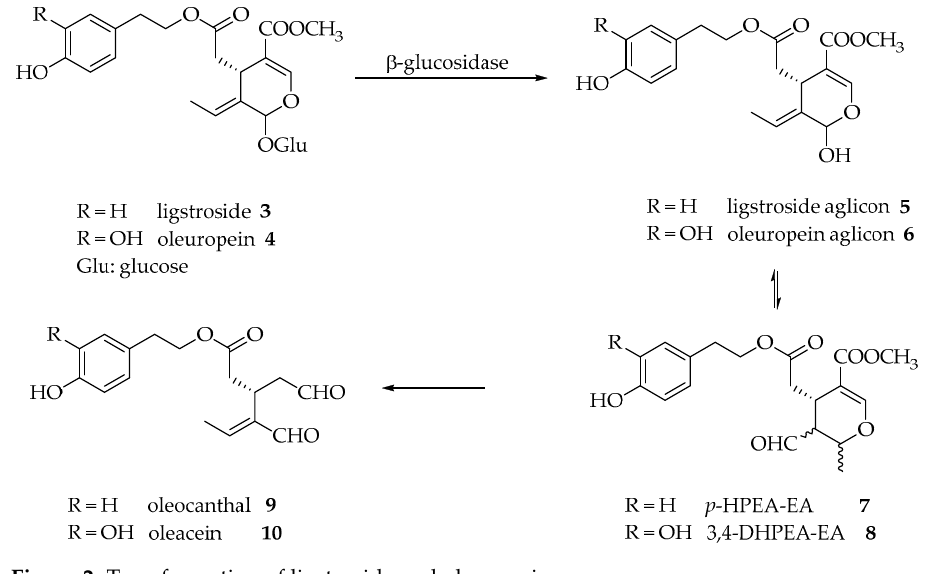
Figure 2. Transformation of ligstroside and oleuropein